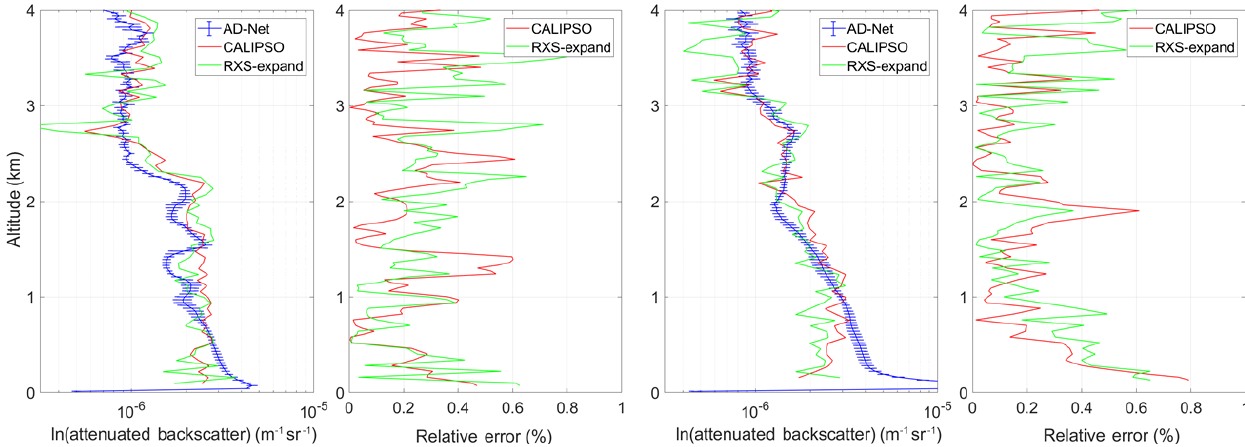
Figure 7. Comparisons among ground-based lidar profiles of 532nm attenuated backscatter coefficient products (units: m − 1 sr − 1 ; averaged 2h within satellite overpass) and CALIPSO profiles at shortest distance and RXS-expand profiles that averaged 25km around the location of Seoul station. The two plots on the left are from 7 March 2015, and the two plots on the right are from 24 April